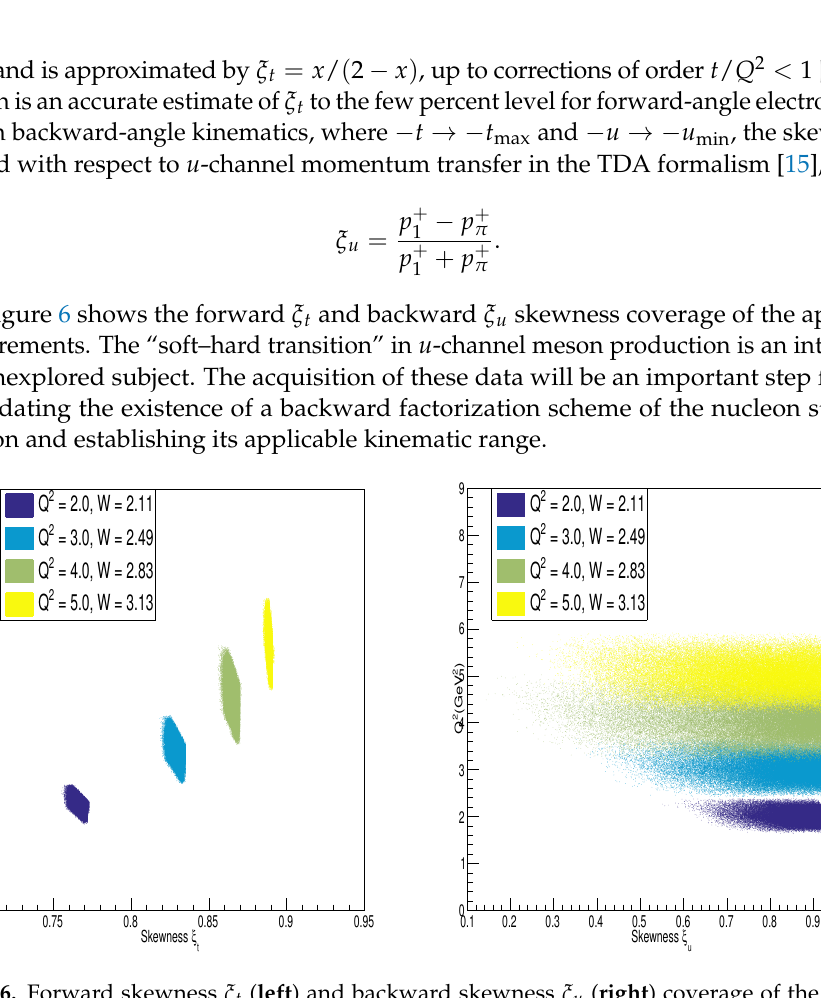
Figure 6. Forward skewness ξ t ( left ) and backward skewness ξ u ( right ) coverage of the planned E12-20-007 measurements for Q 2 = 2.0 to 5.5 GeV 2 (see text for definitions). Clearly the experiment probes a wide kinematic range, which will be helpful for distinguishing the roles of the TDA and Regge reaction mechanisms in the soft–hard transition